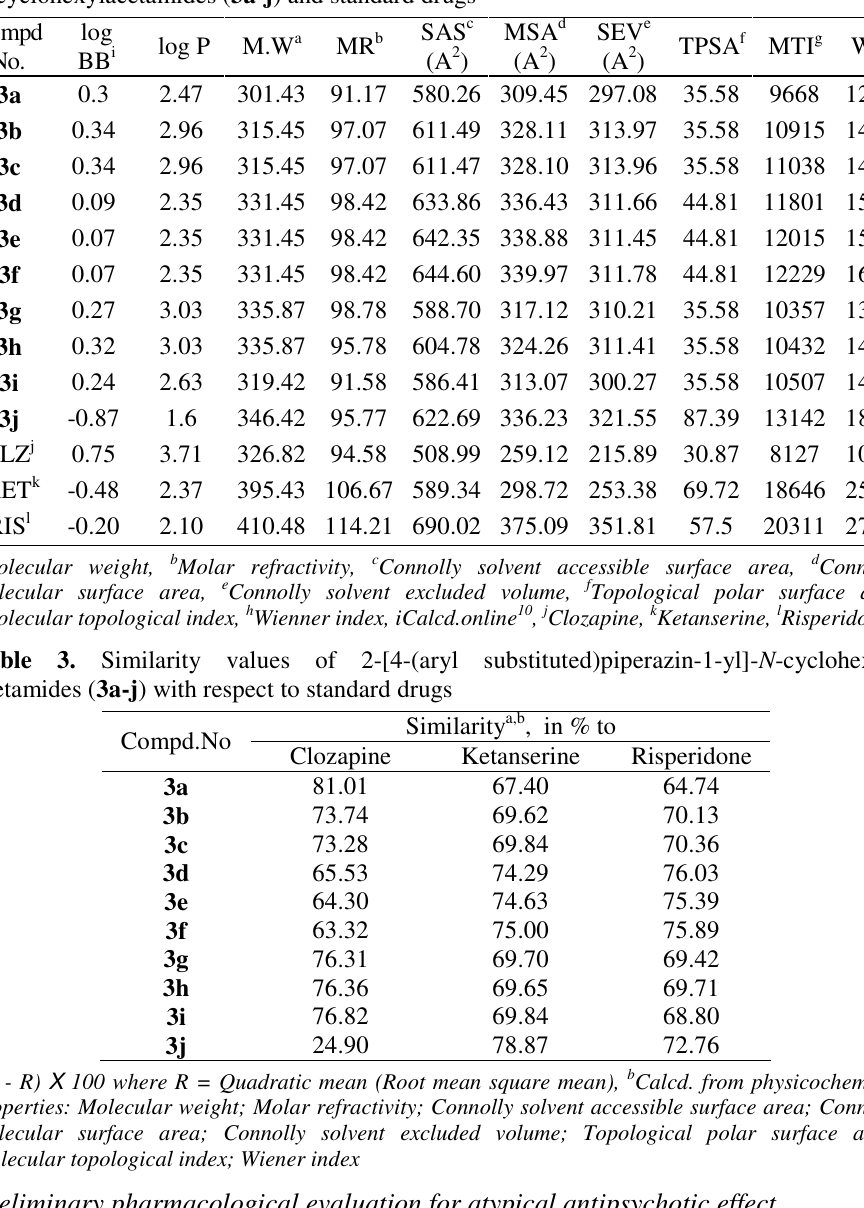
Table 2. Calculation of molecular properties for 2-[4-(aryl substituted) piperazin-1-yl]- N -cyclohexylacetamides ( 3a-j ) and standard